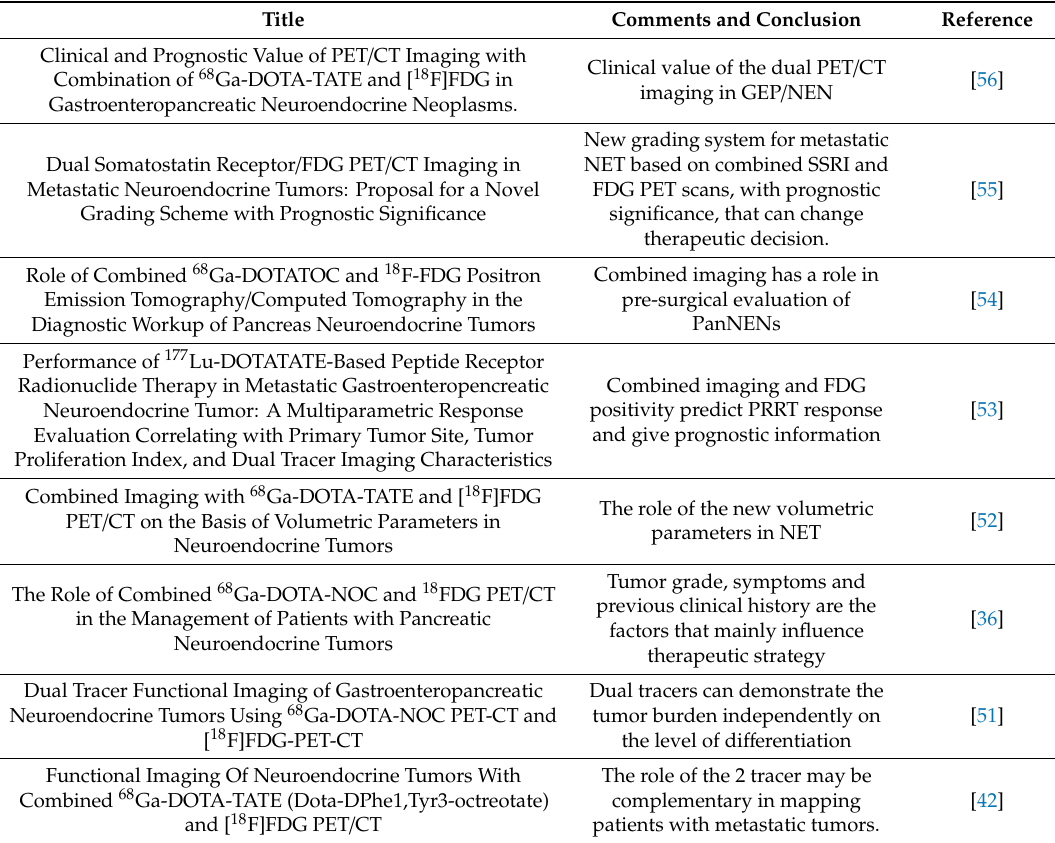
Table 1. Summary of publications in which gastro-entero-pancreatic neuroendocrine neoplasia (GEP-NENs) are studied with 68 Ga-labelled somatostatin (SST) analogues ([ 68 Ga]Ga-DOTA-SST) analogues and 18 F-fluorodeoxyglucose ([ 18 F]FDG).